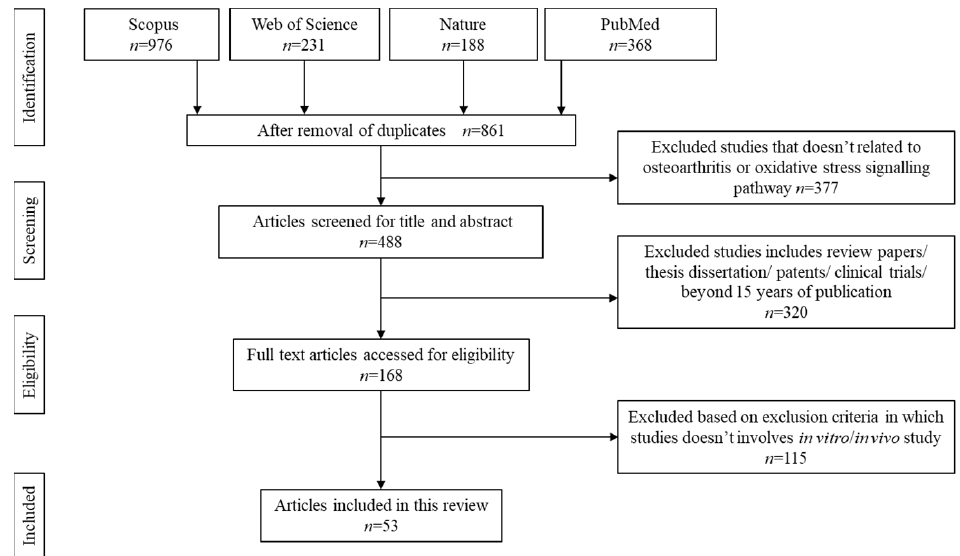
Figure 1. Article search and selection process.